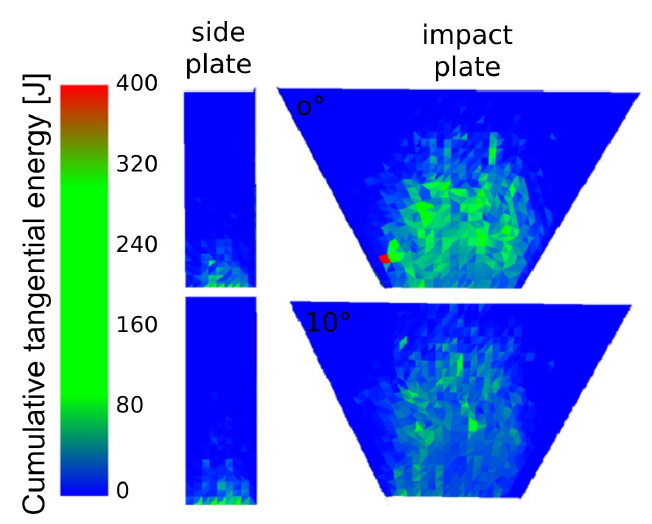
Figure 13. Cumulated tangential energy after 60 s of simulation for the impact plate and the side plate mounted vertically and at an angle of 10° of the structure, for 900